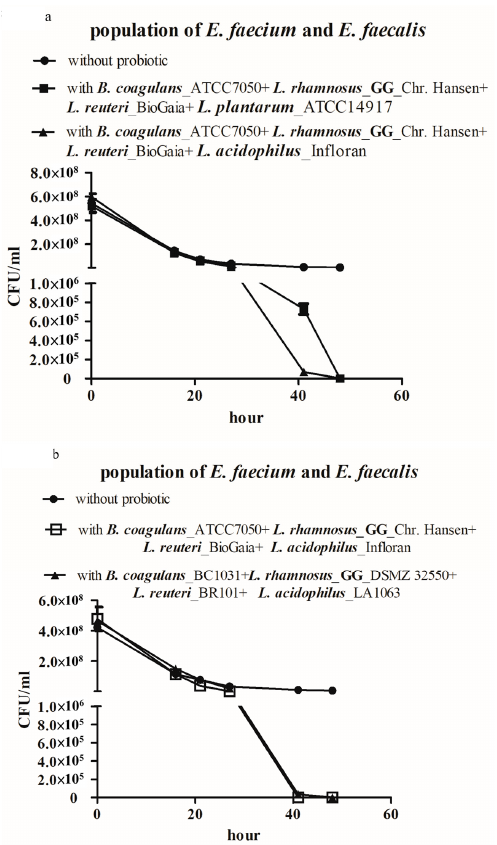
Figure 2. Microbial network analysis (MNA)-assisted identification of critical species for inhibiting VRE from the probiotic mixture. ( a ) The efficacies of L. plantarum _ATCC14917 and L. acidophilus _Infloran in repressing the co-cultured VRE population when in combination with B. coagulans _ATCC7050, L. rhamnosus GG_Chr. Hansen, and L. reuteri _BioGaia were compared. ( b ) Efficacy of suppressing co-cultured VRE population was compared between a combination of probiotic strains B. coagulans _ATCC7050, L. rhamnosus GG_Chr. Hansen, L. reuteri _BioGaia, and L. acidophilus _Infloran and the combination substitutes of the four probiotic strains, BC1031, DSMZ 32550, BR101, and LA1063. 3.2. MNA-Selected Four-Probiotic Mixture Reduced the Number of Co-Cultured VRE More Significantly than Did Individual Strains The efficacies of the mixture of the four probiotic strains in an equal ratio and individual strains were compared to further confirm the necessity of combining the four probiotic strains. In the VRE- probiotic co-culture model, a combination of B. coagulans_ BC1031, L. rhamnosus GG_DSMZ 32250, L. reuteri_ BCRC BR101, and L. acidophilus_ LA1063 (Figure 3a, squares) surpassed B. coagulans_ BC1031 (Figure 3a, diamonds) or L. rhamnosus GG_DSMZ 32,250 (Figure 3a, inverted triangles) alone in